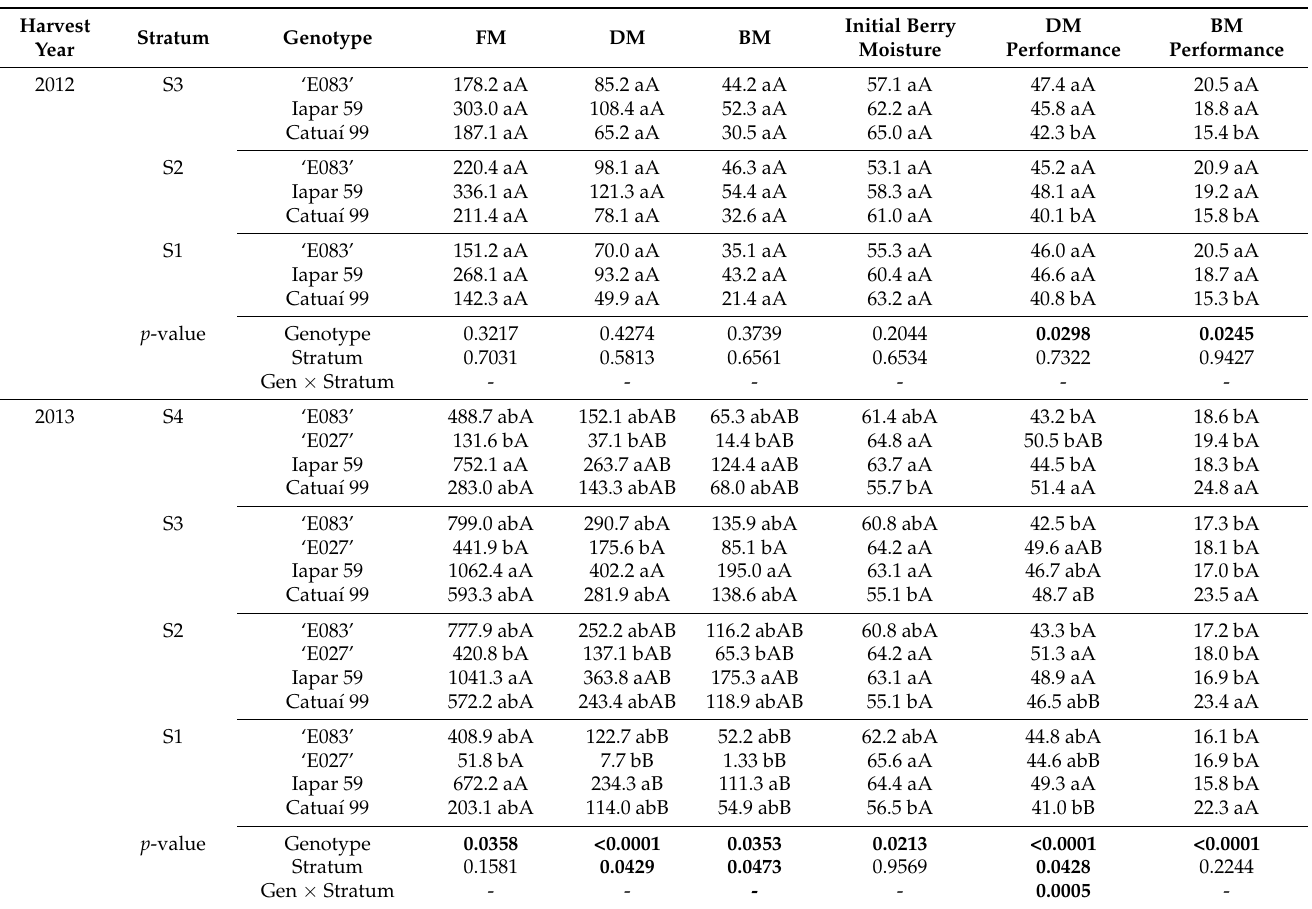
Table 2. Components of the berry and bean yields: fresh berry mass (FM), dry berry mass (DM), and of two harvests (2012 and 2013) analyzed in four genotypes of Coffea arabica along the canopy